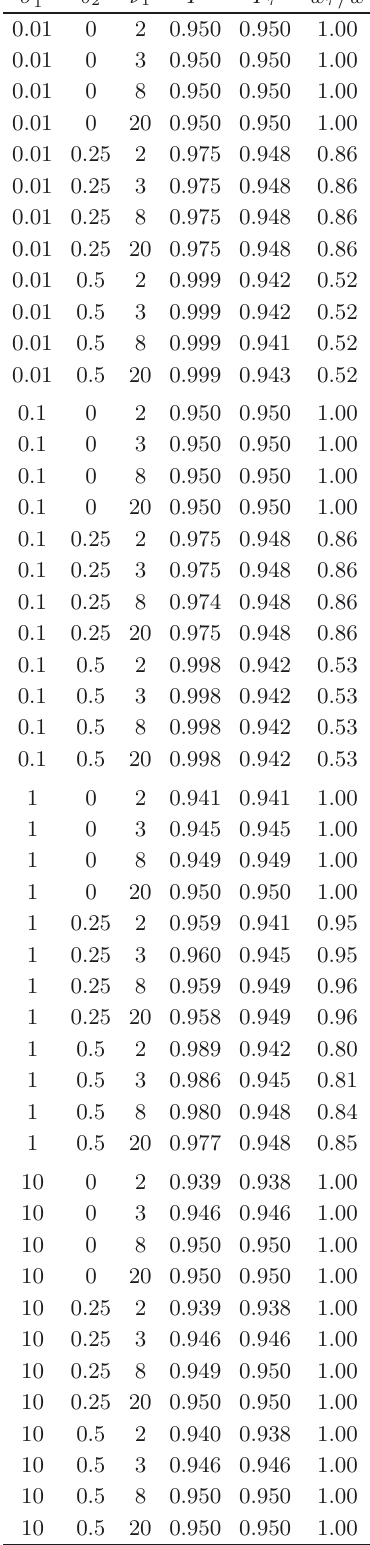
Table 2. Performance results when measuring Y = X 1 + X 2 where x 1 − X 1 is a Type A error and x 2 − X 2 is a Type B error arising from a uniform distribution.